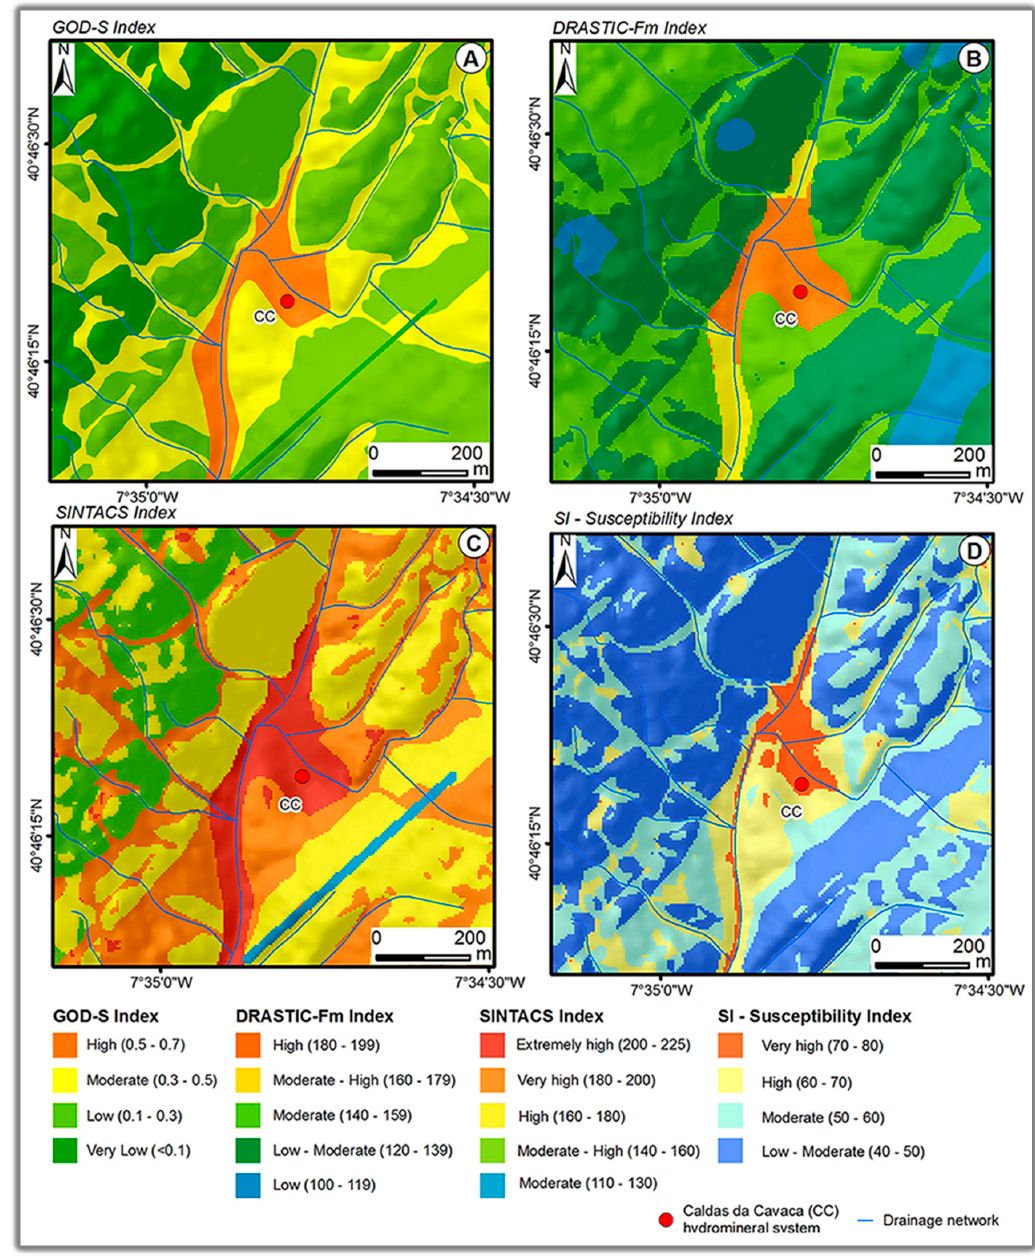
Figure 5. Multicriteria intrinsic vulnerability indexes from Caldas da Cavaca groundwater systems and surrounding area: ( A ) GOD ‐ S; ( B ) DRASTIC ‐ Fm; ( C ) SINTACS; ( D ) SI, revised and updated from [26].